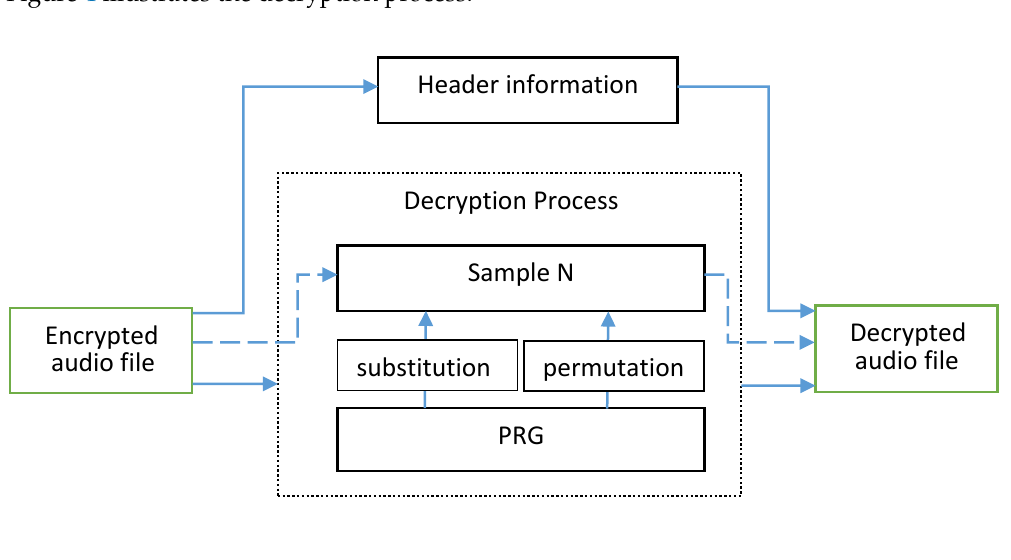
Figure 4. Encryption scheme.